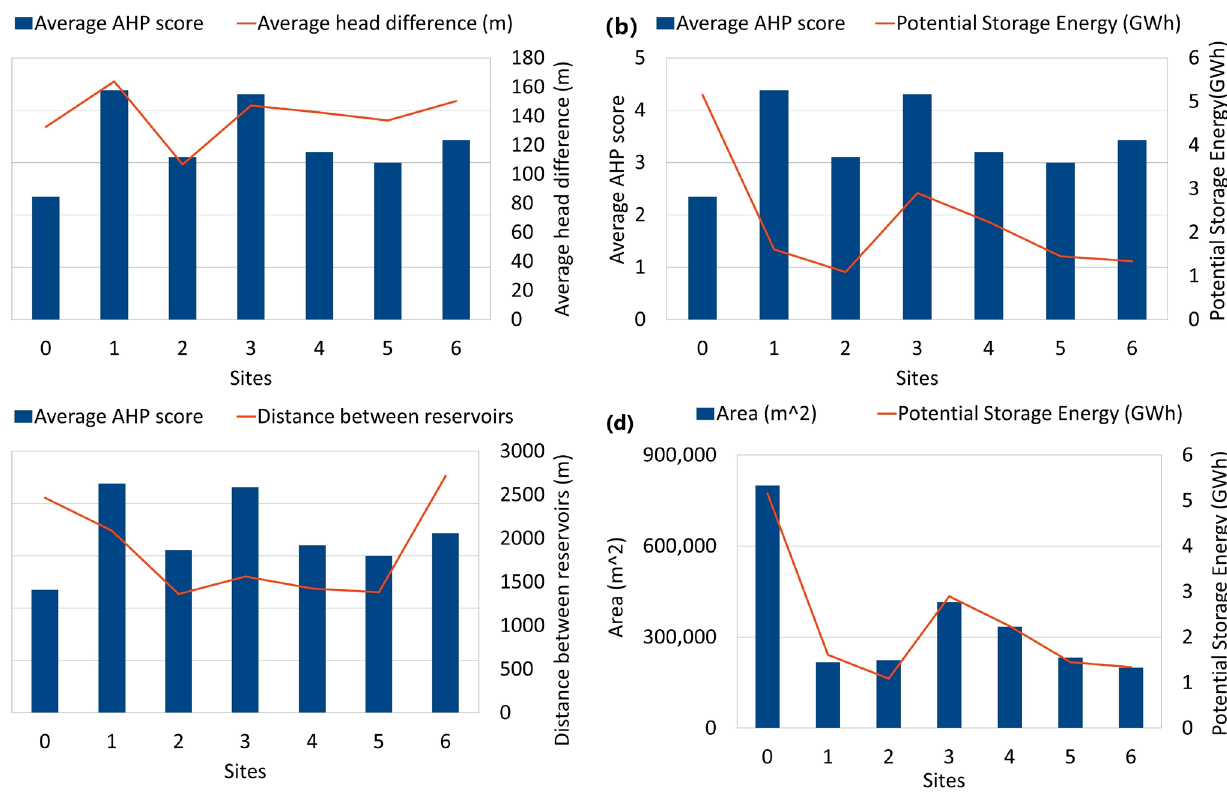
Table 6. Statistical results of AHP scoring for the suggested upper reservoir locations.